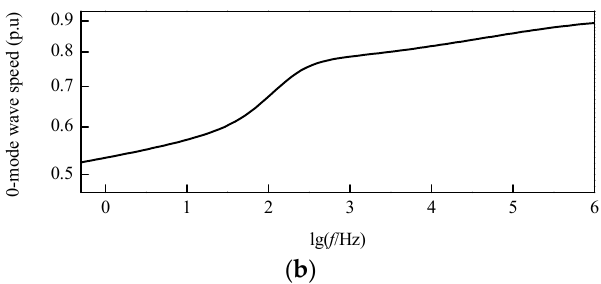
Figure 8. Modulus wave speed characteristic curves: ( a ) 1-mode wave speed; ( b ) 0-mode wave speed.